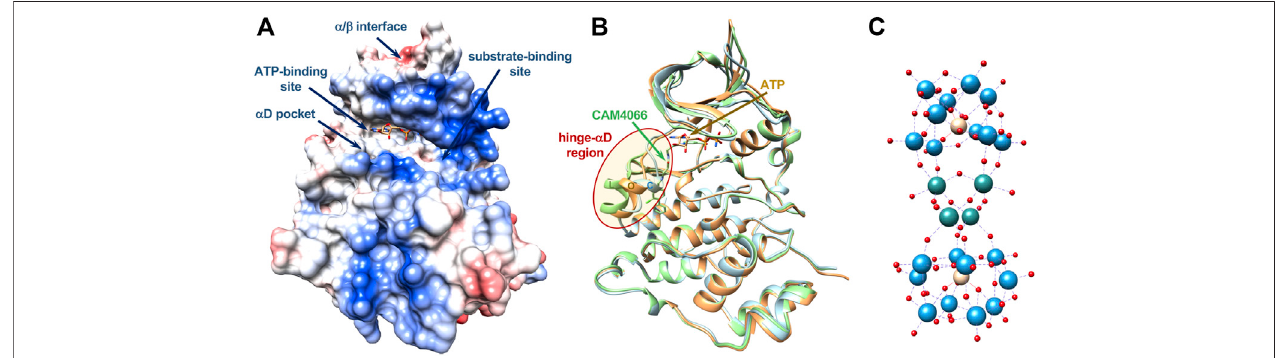
FIGURE 1 | Main interaction sites in catalytic CK2 α . (A) Surface representation, colored according to electrostatics, of the CK2 α -ATP complex (PDB-code 3NSZ); main interactions sites targeted by different classes of inhibitors discussed in the text are shown. Location of allosteric sites are uncertain as well as binding sites for POMs. (B) Ribbon representation of three structures of CK2 α showing the conformational variability of the very mobile hinge- α D region (red oval), which can adopt a closed (C, in cyan), open (O, in orange) or large (L, in green) conformation (PDB-codes 3Q9W, 3NSZ, and 5CU3, respectively). The α D pocket is created with the “ large ” conformation, in presence of speci fi c ligands such as CAM4066, shown in green. Bound ATP is shown (carbon atoms in orange). (C) Molecular structure of